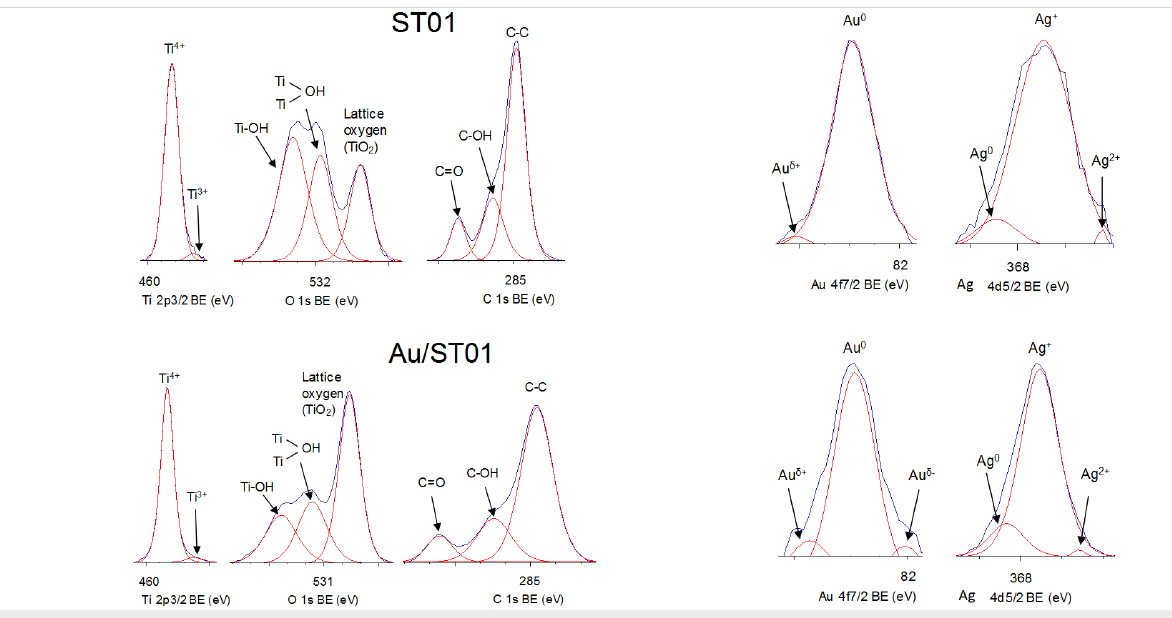
Figure 2: XPS spectra for bare (top left) and gold-modified (bottom left) TiO 2 (ST01) sample, and deconvoluted peaks of Au 4f 7/2 (center) and Ag 3d 5/2 (right) for metal-modified ST01 (top) and ST41